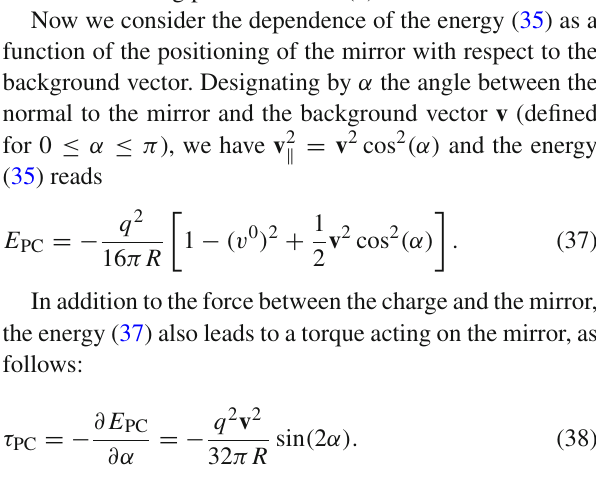
Fig. 1 Plot for τ PC , with q 2 v 2 /( 32 π R ) = 1, as a function of α . The torque vanishes for α = 0 ,π/ 2 ,π and two extrema values for α = π/ 4 , 3 π/